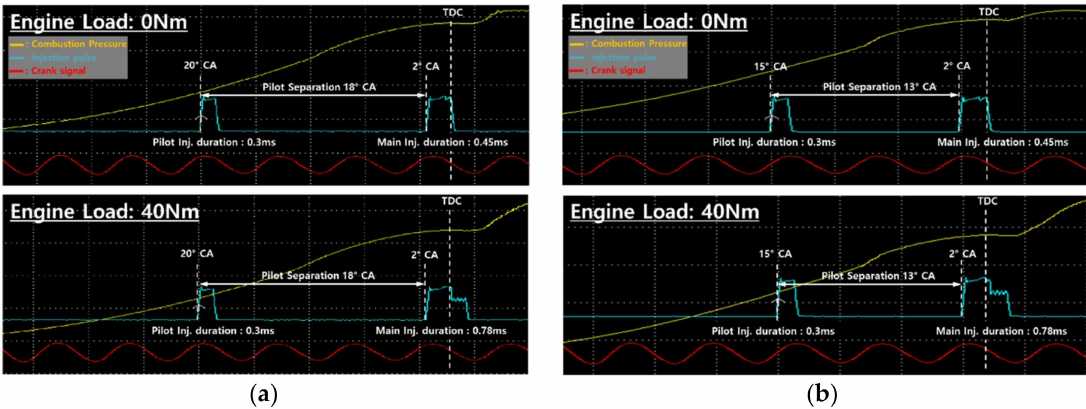
Figure 2. Injection timings and duration of pilot and main. ( a ) Main BTDC 2 ◦ CA, pilot BTDC 20 ◦ CA (separation 18 ◦ CA), ( b ) main BTDC 2 ◦ CA, pilot BTDC 15 ◦ CA (Separation 13 ◦